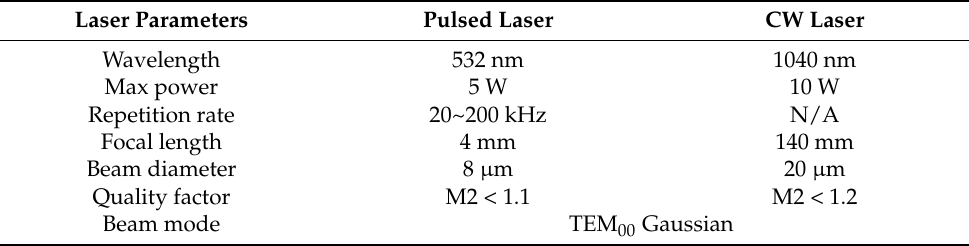
Table 1. Main parameters of the lasers.